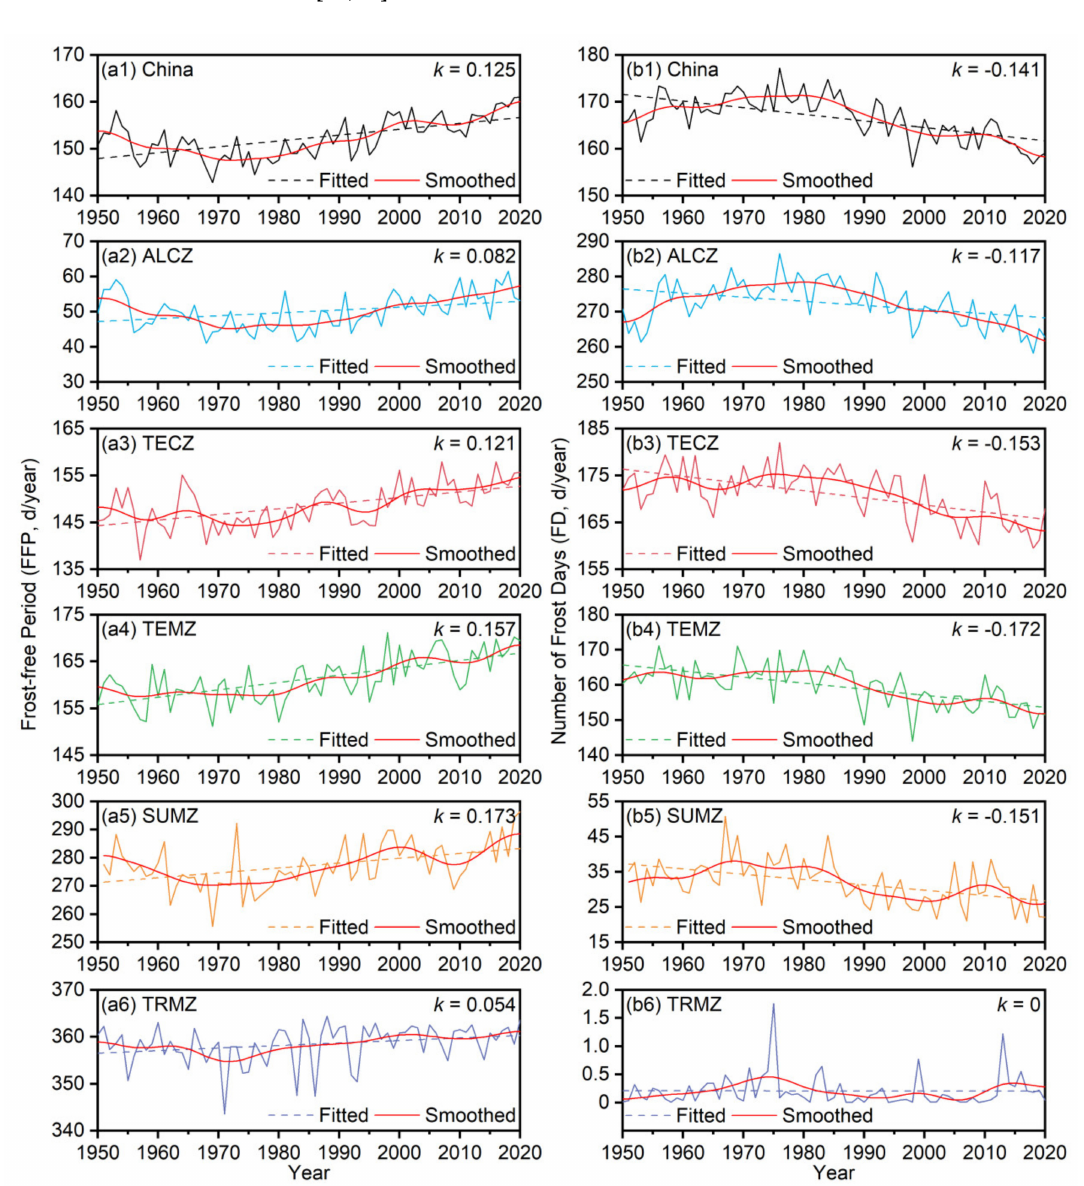
Figure 7. Interannual trends and variations of FFP and FD for China and different climate type zones in China during the 1950~2020. k represents the degree of variation in annual FFP and FD, respectively, i.e., the slope of the data variation. ( a1 – a6 ) Annual FFP; ( b1 – b6 ) Annual